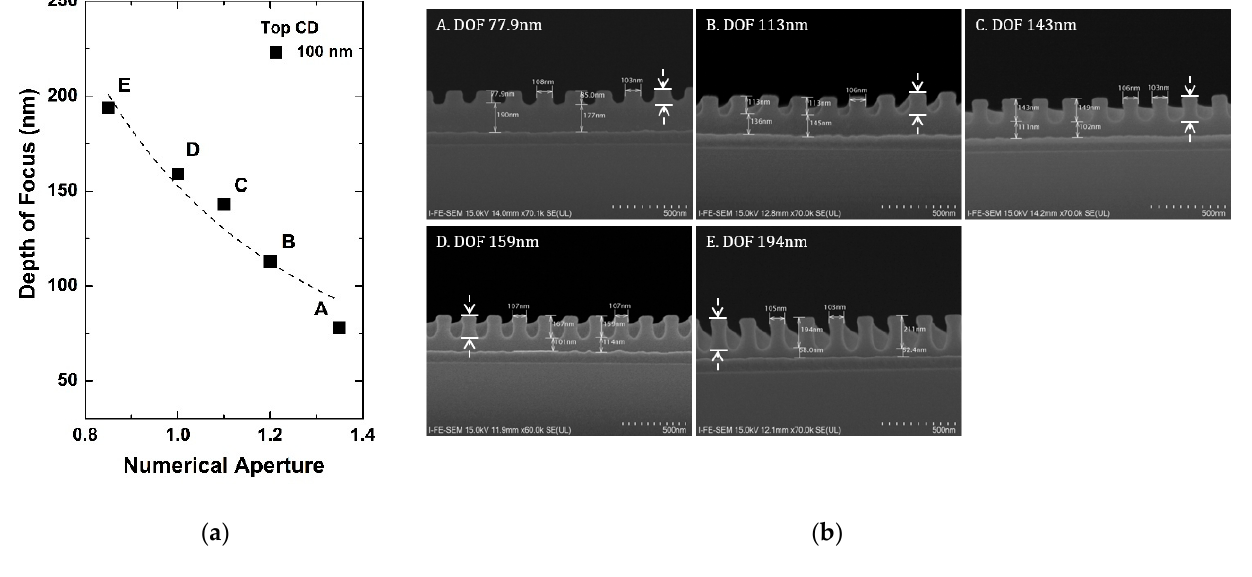
Figure 3. ( a ) Extracted depth of focus according to NA in 1:1 line and space pattern with 100 nm, and ( b ) FE SEM analysis of the pattern (cross view). Here, the photoresist thickness is enlarged to 2400 Å to find out the depth of focus experimentally. The dashed arrows indicate the depth of focus.